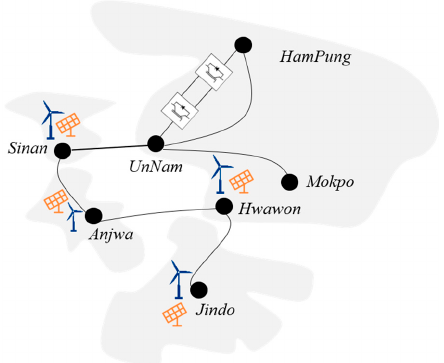
Figure 4. MVDC link candidate #1. HamPung-UnNam connection.